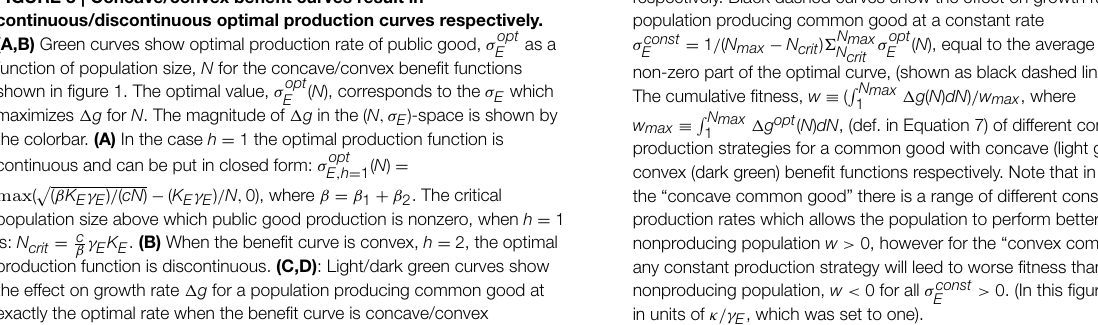
FIGURE 3 | Concave/convex benefit curves result in continuous/discontinuous optimal production curves respectively. (A,B) Green curves show optimal production rate of public good, σ opt E as a function of population size, N for the concave/convex benefit functions shown in figure 1. The optimal value, σ opt E ( N ) , corresponds to the σ E which maximizes 1 g for N . The magnitude of 1 g in the ( N ,σ E ) -space is shown by the colorbar. (A) In the case h = 1 the optimal production function is continuous and can be put in closed form: σ opt E , h = 1 ( N ) = max ( ( β K E γ E ) / ( cN ) − ( K E γ E ) / N , 0) , where β = β 1 + β 2 . The critical p population size above which public good production is nonzero, when h = 1 is: N crit = c β γ E K E . (B) When the benefit curve is convex, h = 2 , the optimal production function is discontinuous. (C,D) : Light/dark green curves show the effect on growth rate 1 g for a population producing common good at exactly the optimal rate when the benefit curve is concave/convex